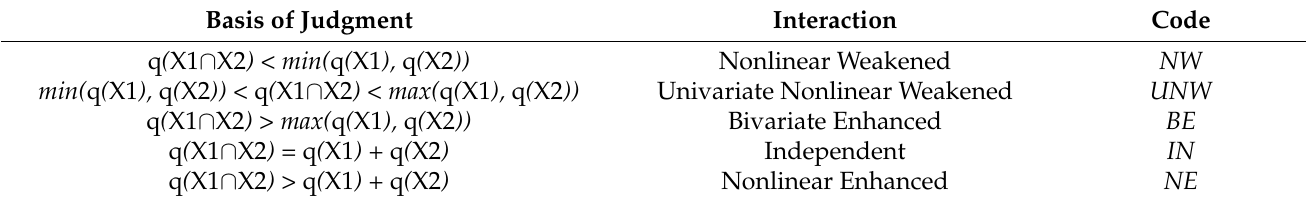
Table 1. Factor interaction